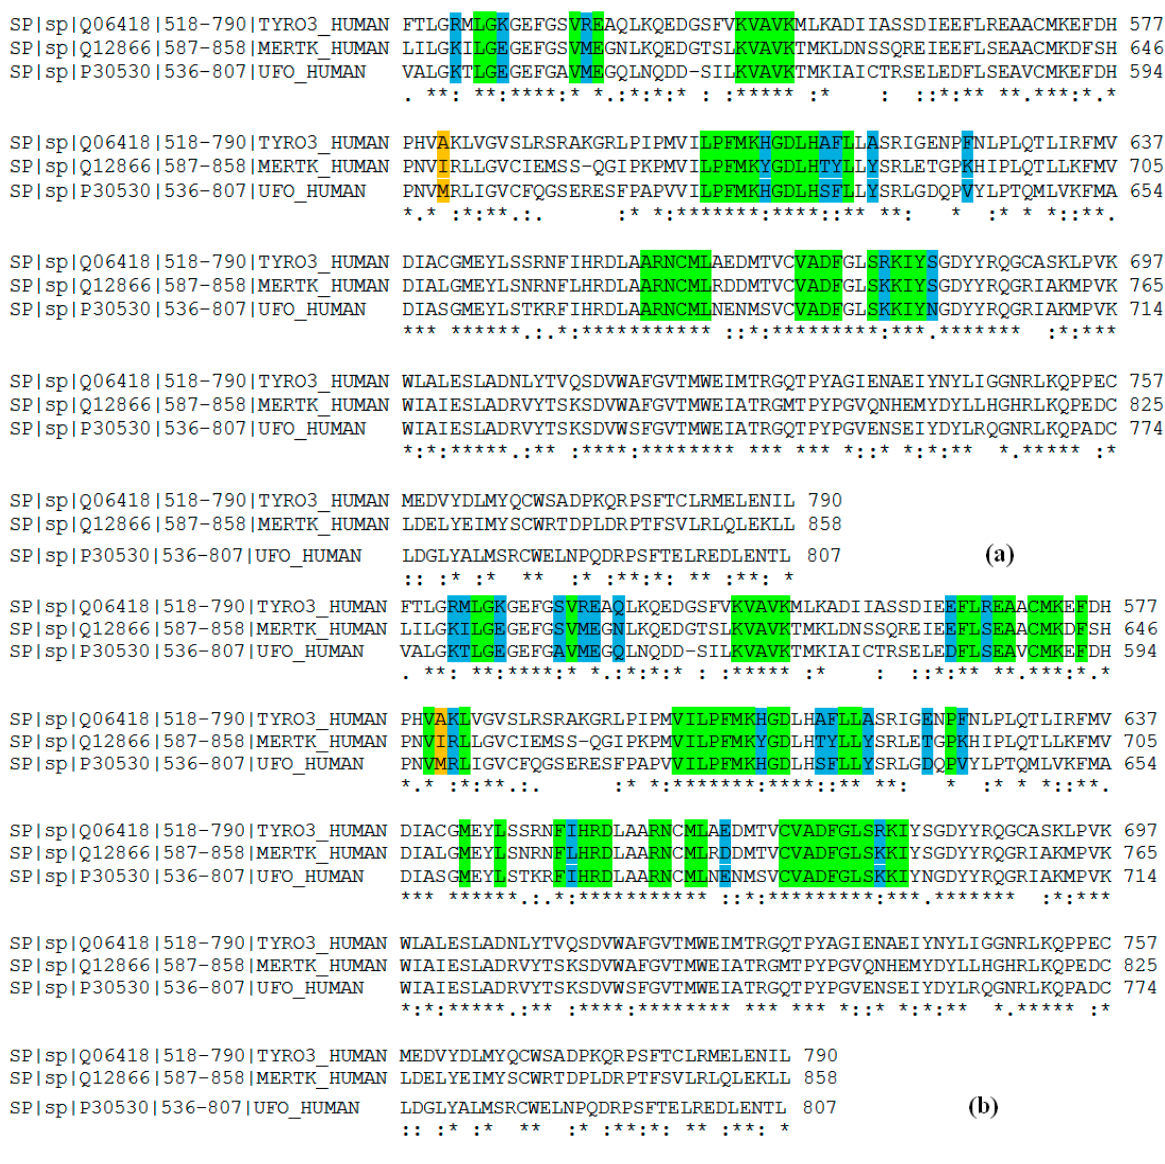
Figure 5. Alignment of the three TAM kinase domains. The active site is highlighted at 6 Å from the docked ligands. Identical residues are shown in green; non-conserved residues; in blue; and the key residue for each kinase, in orange. ( a ) Sequence alignment for the DFG-Asp in conformation. ( b ) Sequence alignment for the DFG-Asp out